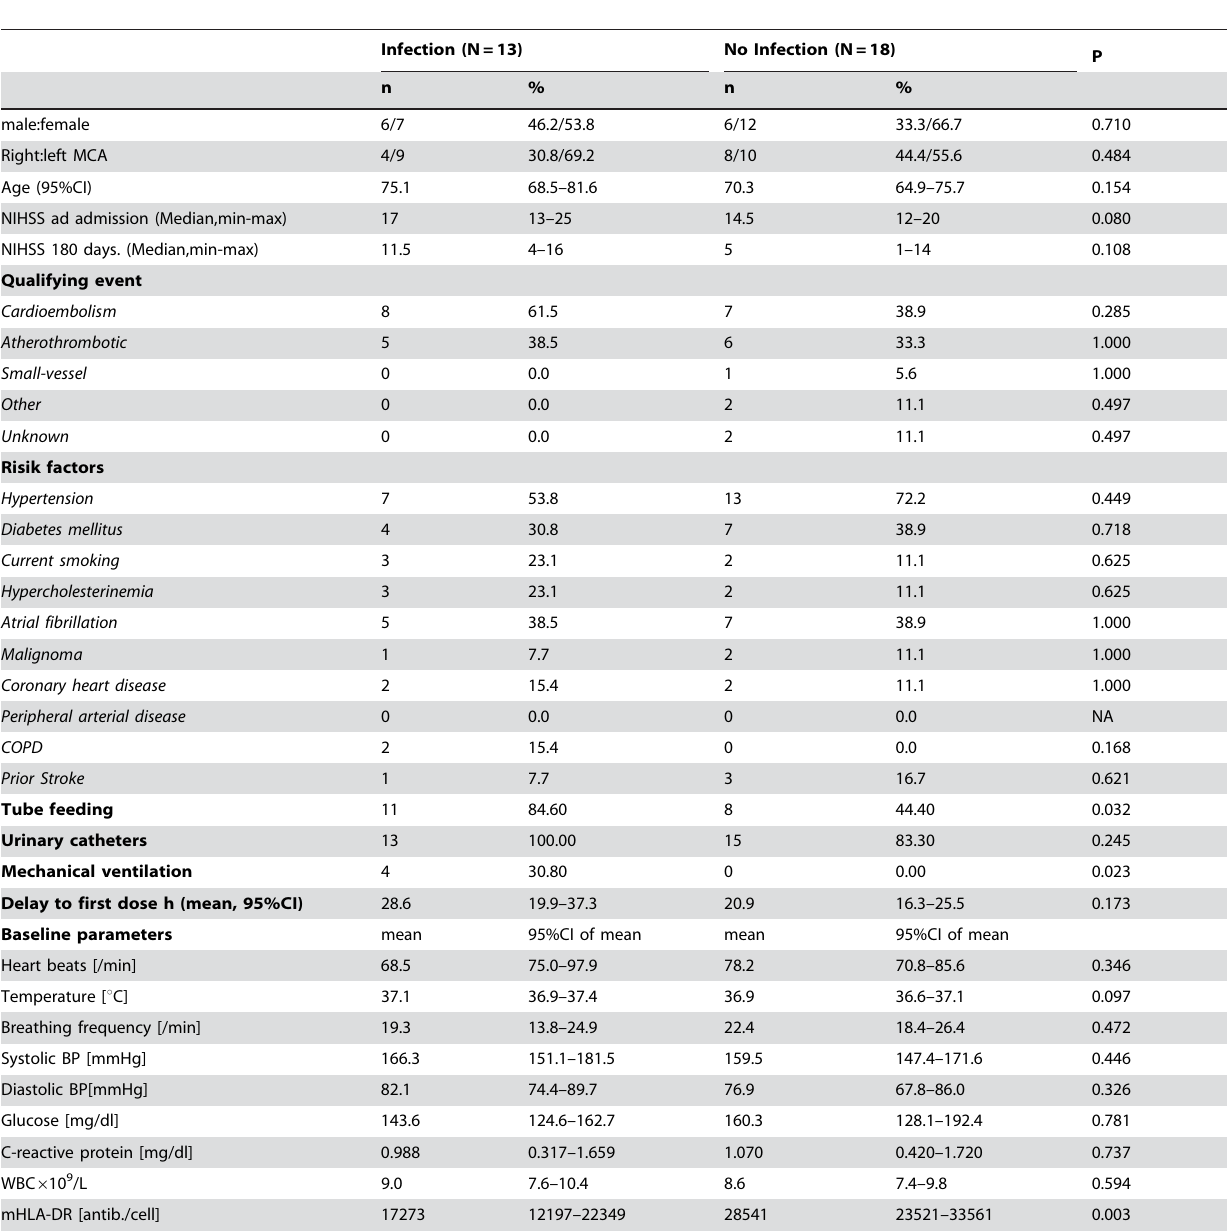
Table 5. Univariate analysis for predictors of post-stroke infections in the placebo arm of PP population.